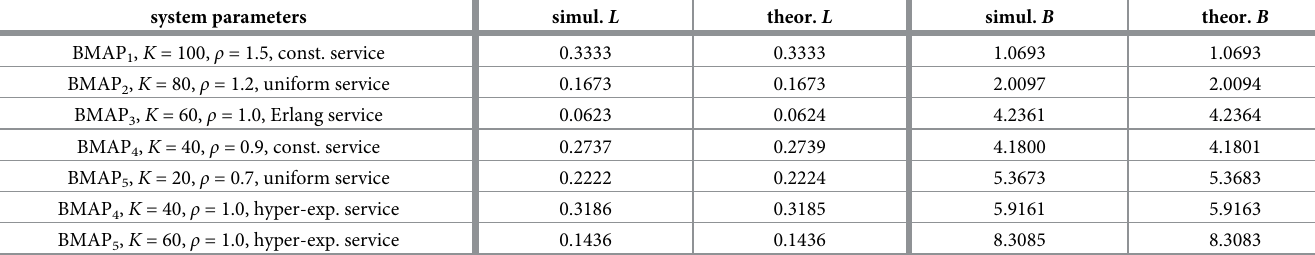
Table 2. Simulated and theoretical loss and burst ratios for different system